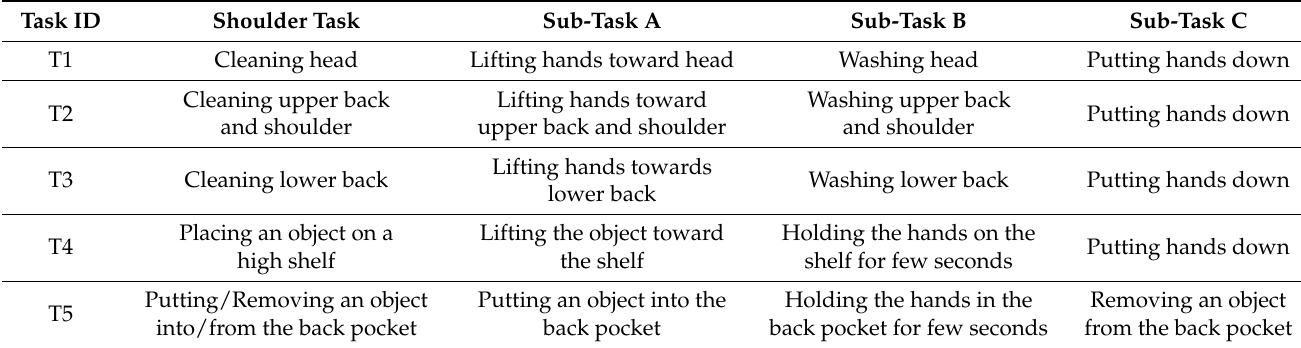
Table 1. A list of shoulder task and sub-task.